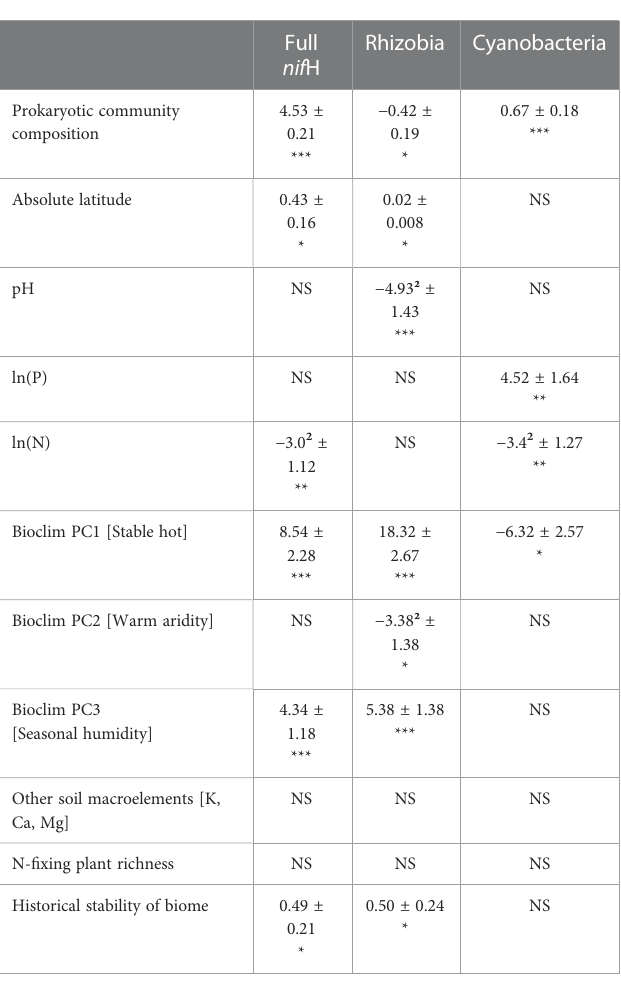
TABLE 1 Factors affecting the natural logarithm of richness of different groupings of N- fi xing prokaryotes in the nitrogenase reductase nif H